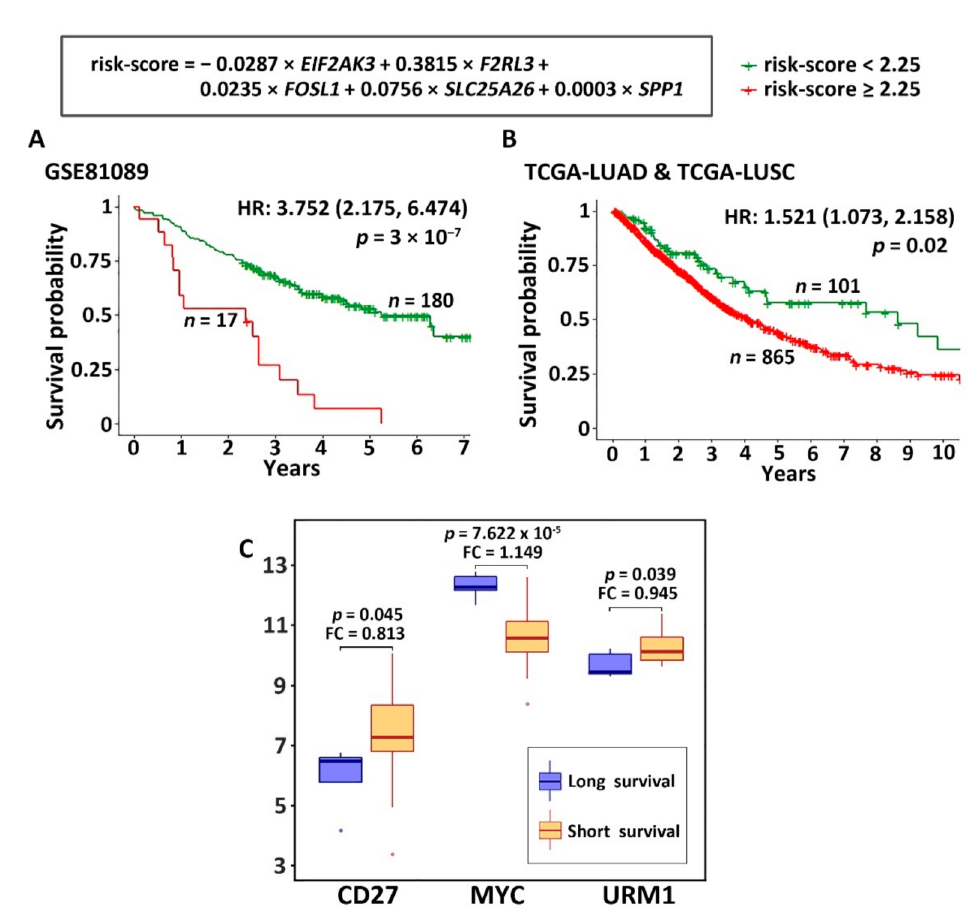
Figure 5. The 5-gene prognostic model for NSCLC. ( A ) Kaplan–Meier analysis of patients grouped by risk-scores with the cutoff value of 2.25 in GSE81089. ( B ) Kaplan–Meier analysis of patients stratified by risk-scores with the cutoff value of 2.25 in TCGA-LUSC and TCGA-LUAD. The plot shows the results of first 10 years after surgery. ( C ) Genes associated with radiotherapy response. These genes had a significant differential expression ( p < 0.05, two-sample t -tests) in the long survival group versus the short survival group in TCGA-LUSC and TCGA-LUAD. Stage III or IV patients who had received radiotherapy were included in the analysis. FC: fold change of gene expression in the long survival versus the short survival patient